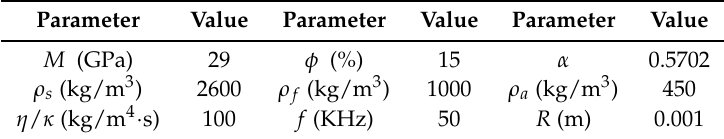
Table 1. Experimental parameters [18].